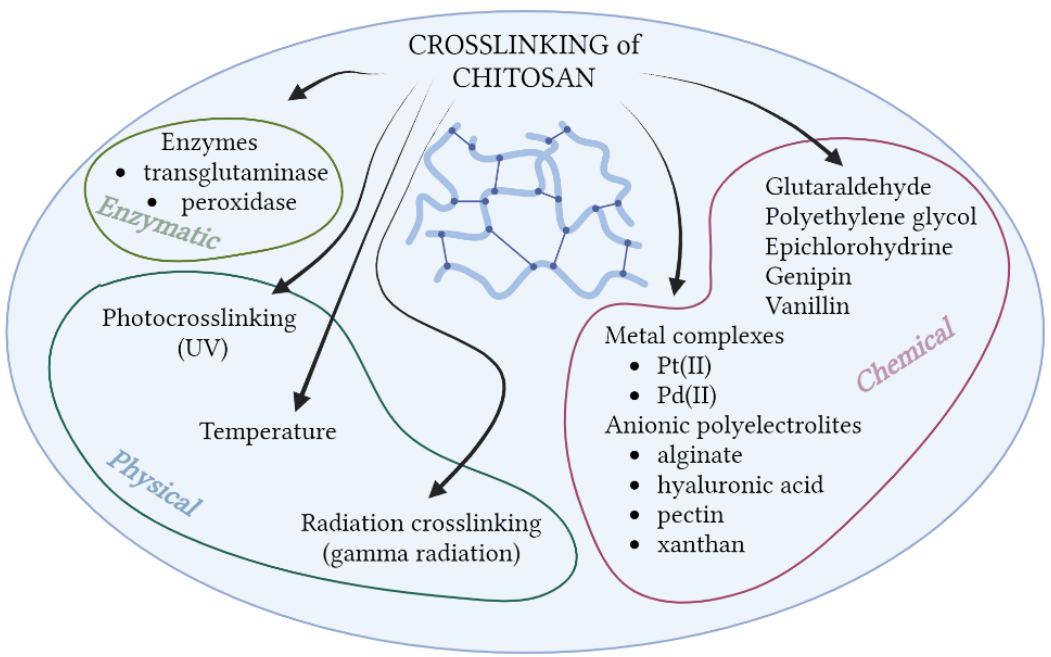
Figure 8. Crosslinking agents for chitosan (Created with BioRender.com; accessed on 18 January 2023).